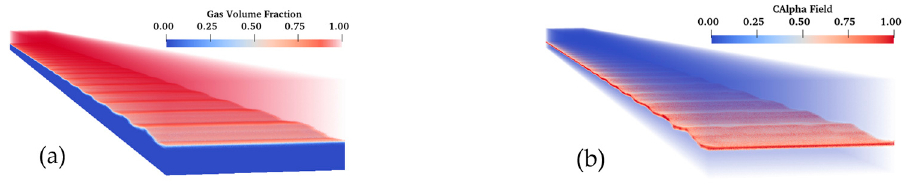
Figure 3. CFD results of the distribution of the gas volume fraction ( a ) and C α ( b ) for the 400 experiment of Fabre et al. [30].